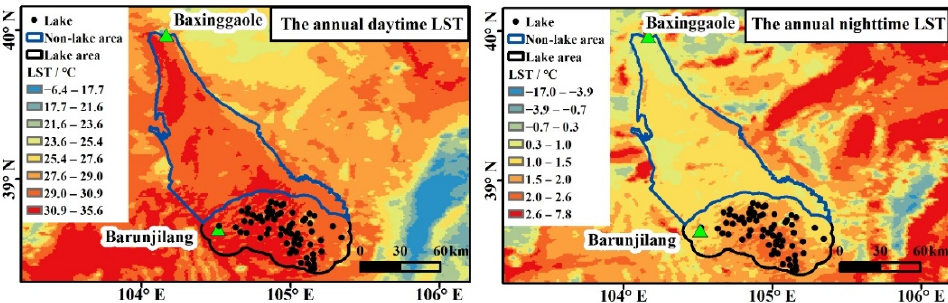
Figure 2. Distribution of average LST during the daytime and nighttime in the lake and non-lake areas from 2003 to 2018.